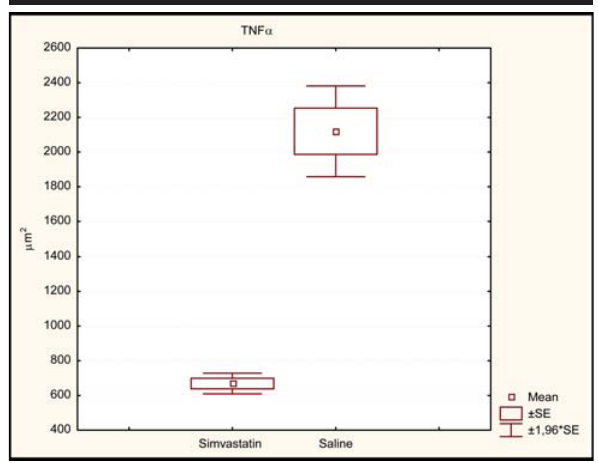
table 1. So, a distinct decrease of tissue reactivity occurred when the simvastatin microemulsion was applied to the infected wounds.